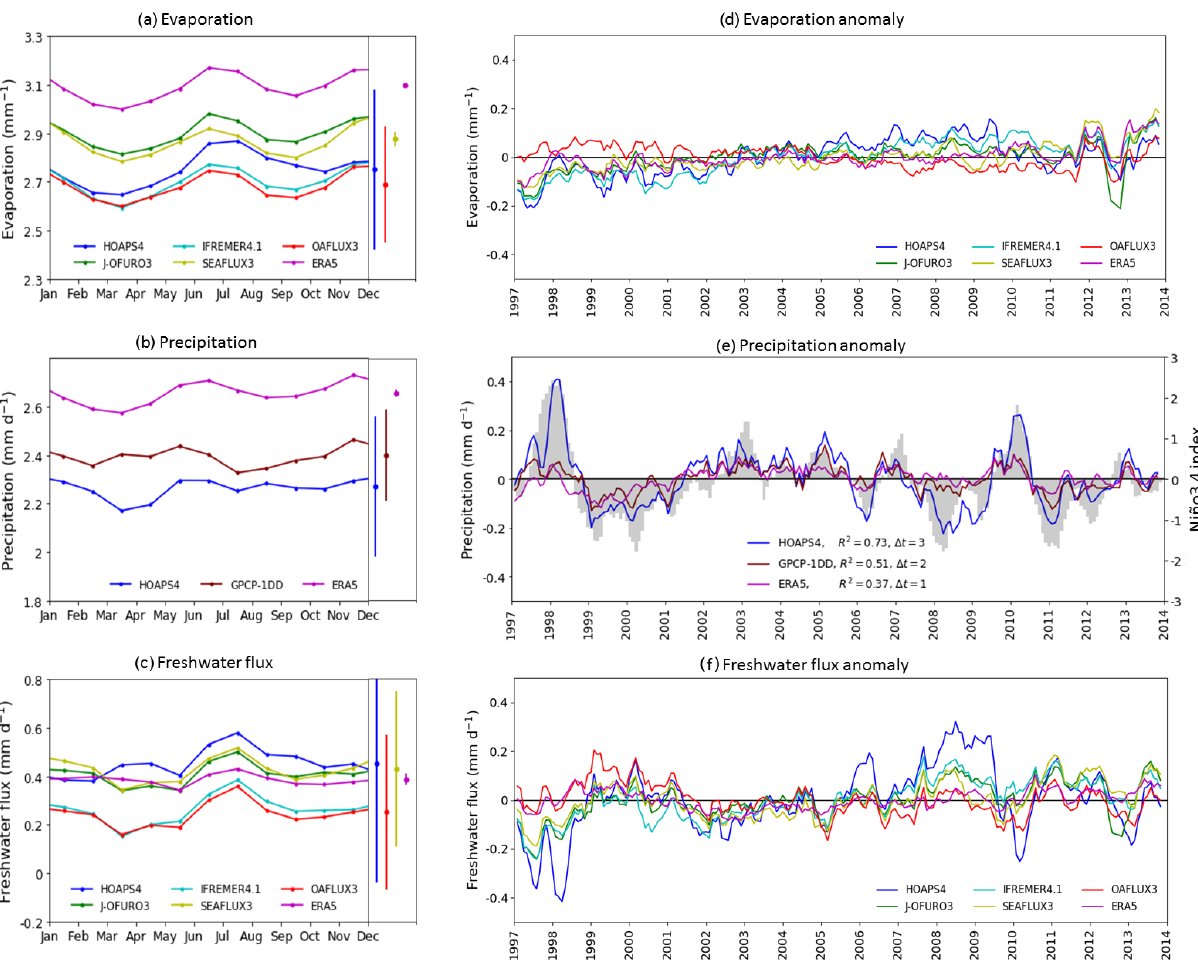
Figure 3. Climatological (1997–2013) seasonal cycle of global ocean mean evaporation rate (a) , precipitation rate (b) , and freshwater flux (c) . HOAPS, ERA5, OAFlux, SEAFLUX, and GPCP mean values and associated 1 σ uncertainty ranges are shown in the boxes to the right of the panels. Monthly mean anomaly (with respect to the climatological seasonal cycle depicted on the left) over the global oceans (80 ◦ S–80 ◦ N) of evaporation rate (d) , precipitation rate (e) , and freshwater flux (f) . The anomaly data are smoothed using a 3-month running mean. Panel (e) additionally displays the Niño3.4 index shifted by + 3 months (right y axis). The legend shows the correlation coefficient of the Niño3.4 index with P anomalies and the time lag of highest correlation ( (cid:49)t in months). Ticks on the time axis mark January of the indicated